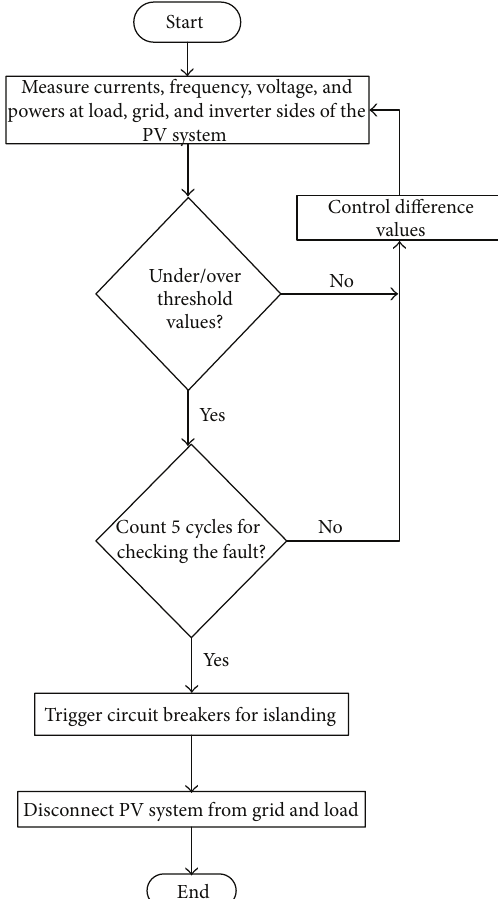
Figure 7: Proposed islanding detection